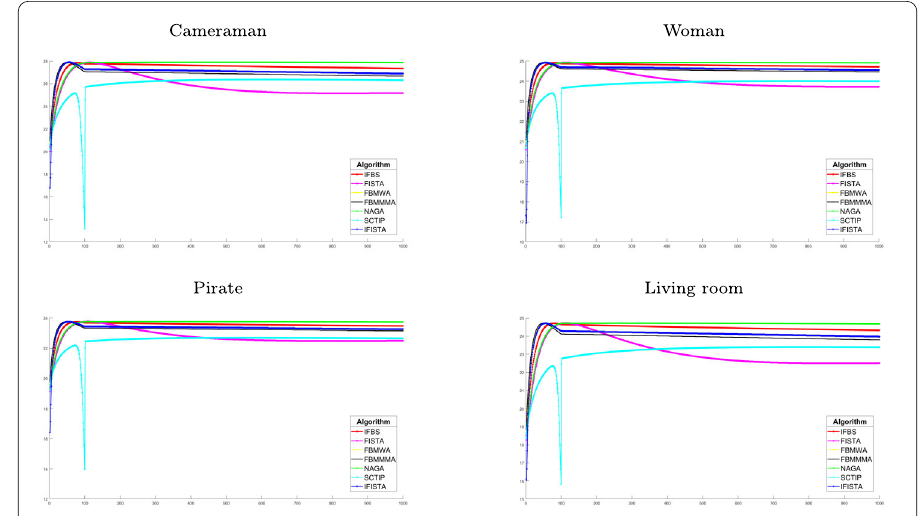
Figure 3 The SNR convergence behavior of image deblurring